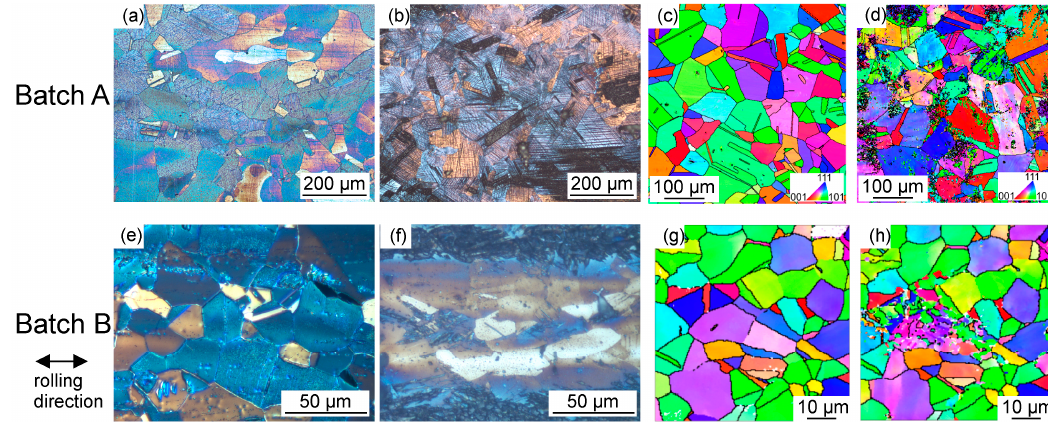
Figure 2. Optical micrographs of longitudinal sections using Bloech & Wedl I etching ( a , e ) initial state, ( b , f ) after plastic deformation as well as EBSD grain maps of ( c , g ) initial state and ( d , h ) after plastic deformation.